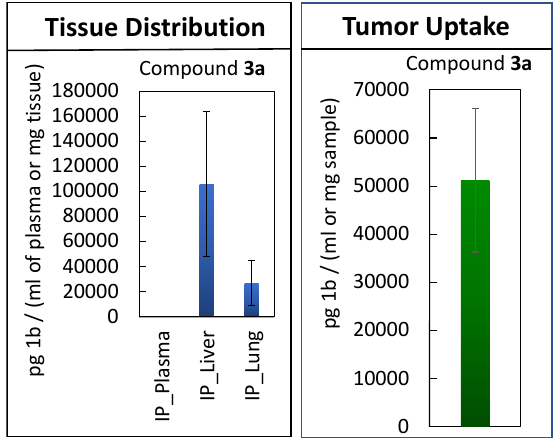
Figure 8. Analysis of tissue distribution and tumor uptake of 3a . Proteins were precipitated from serum by treatment with LC-MS grade methanol in a 1:3 ratio. Liver, lung, and tumor samples were mixed with 80% methanol (10 mg:400 µ L), homogenized, and the insoluble materials were pelleted by centrifugation to separate the supernatants. All samples were stored at 4 ◦ C until analysis. The levels of 3a in each sample were determined using ultra-performance liquid chromatography coupled to mass spectrometry (UPLC-MS).